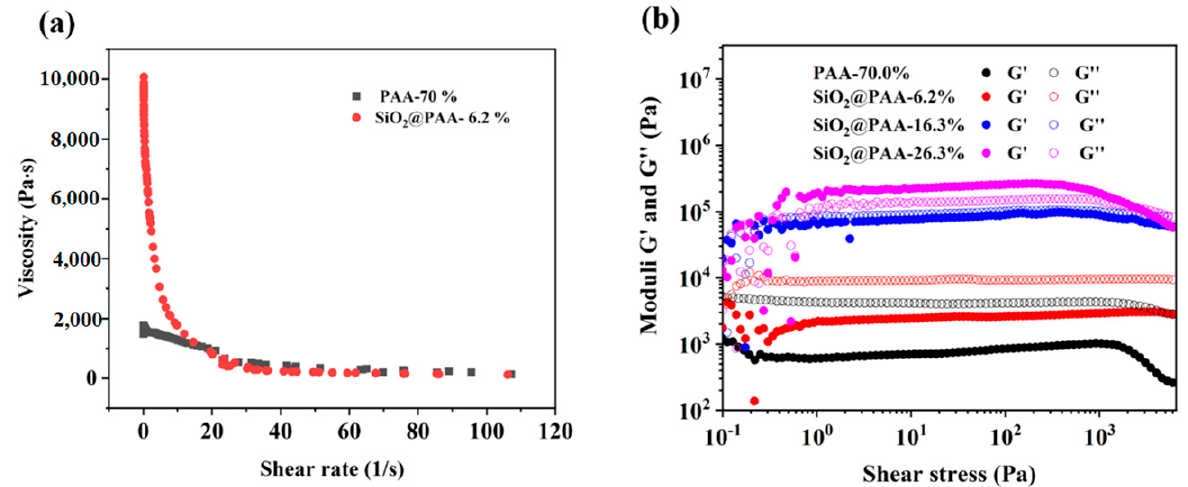
Figure 3. ( a ) Viscosity as a function of shear rate; ( b ) storage moduli and loss moduli as a function of shear stress.